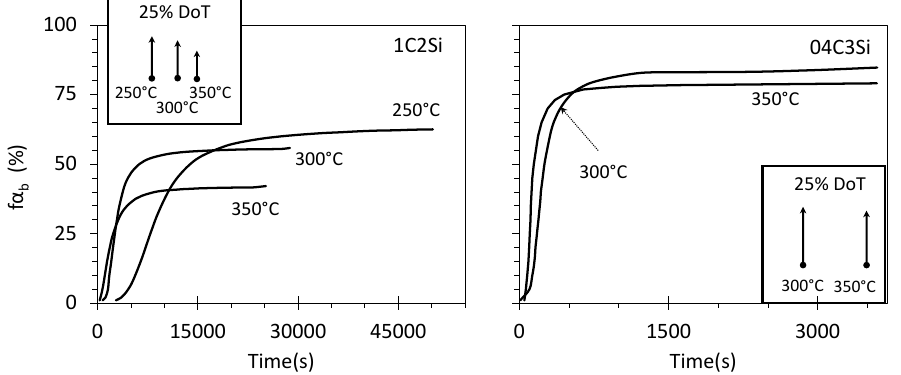
Figure 6. Evolution of the fraction of bainitic ferrite, f α b , as a function of time. Arrows correspond to the 25% degree of transformation (DoT) at the indicated T Iso .